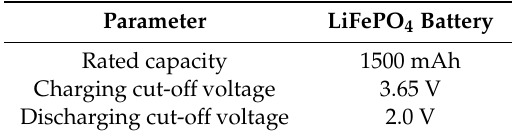
Table 1. Specifications for the test battery at 25 °C.